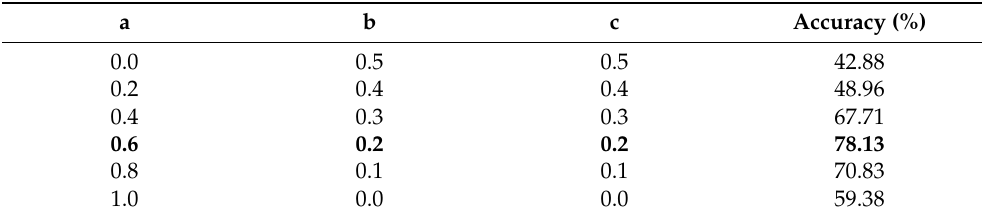
Table 1. Values of the weighting parameters a , b , and c , and associated accuracy of the root system architecture (RSA) reconstruction. Numbers in bold indicate the highest accuracy achieved for the root point connection.